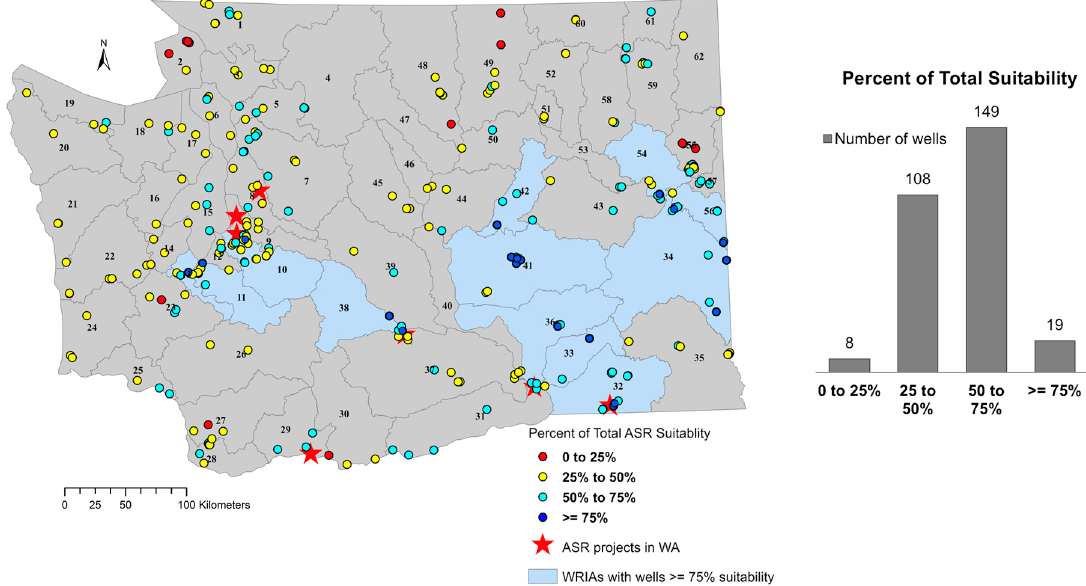
Figure 7. Results from the Site Scoring System in Percent of Total ASR Suitability at each site. Subcatagory Results